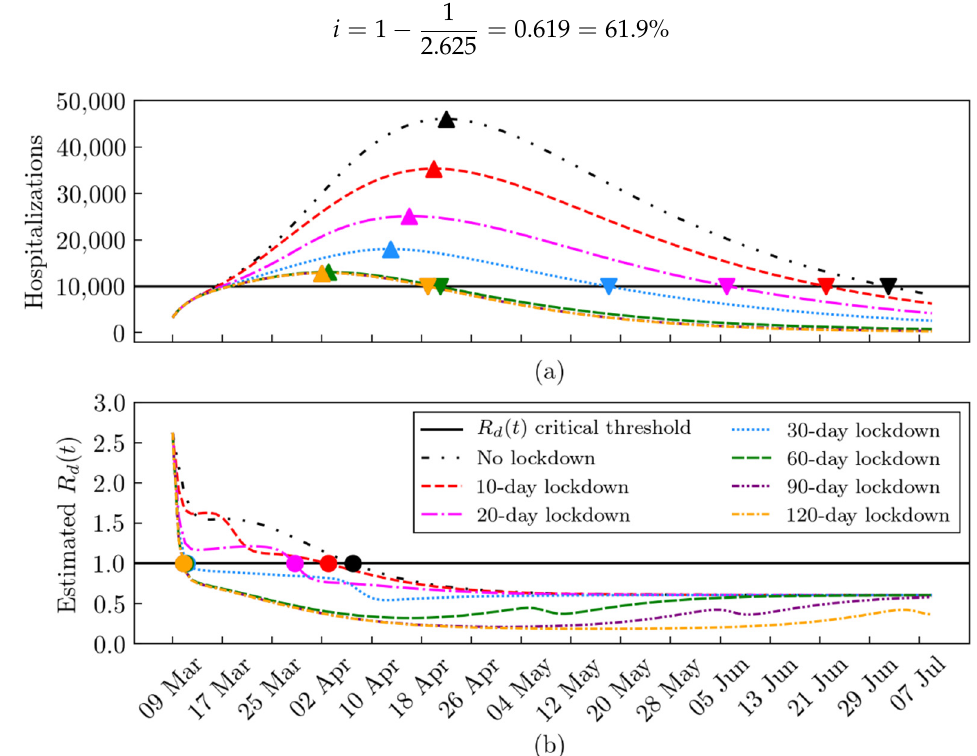
Figure 4. What-if Analysis based on different lockdown duration scenarios during the first wave and R d ( t ) estimation. ( a ) BSM best setting predicted hospitalizations based on different lockdown scenarios, with estimated hospitalization peaks (upward triangles) and days when the hospitaliza- tion reference threshold is reached (downward triangles), e.g., 10,000. ( b ) for each scenario, the corresponding daily reproduction number R d ( t ) is reported along with the estimated days (circles) in which the critical threshold is